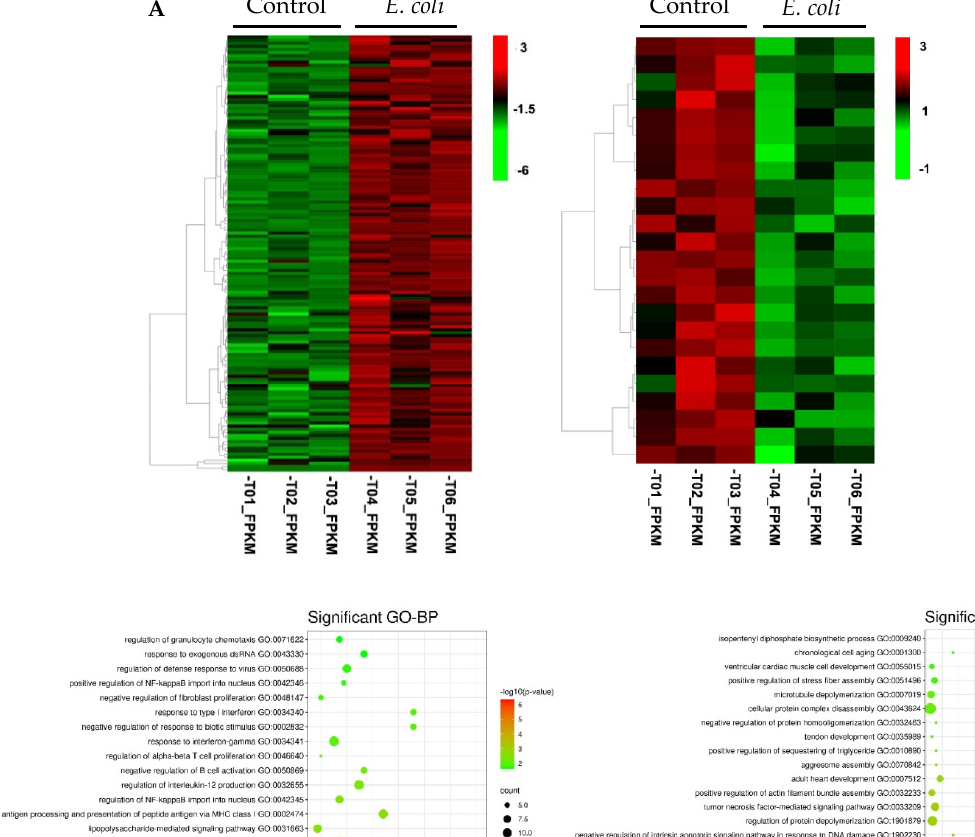
( C ) Venn diagram comparing the gene expression changes induced by heated-killed E. coli or S. aureus . ( D ) Expression patterns of the overlapping differentially expressed transcripts between E. coli - and S. aureus -stimulated cells compared with control showing in ( C ). Results are expressed as log2FC over unstimulated control cells. Data are mean ± s.d. of triplicates.